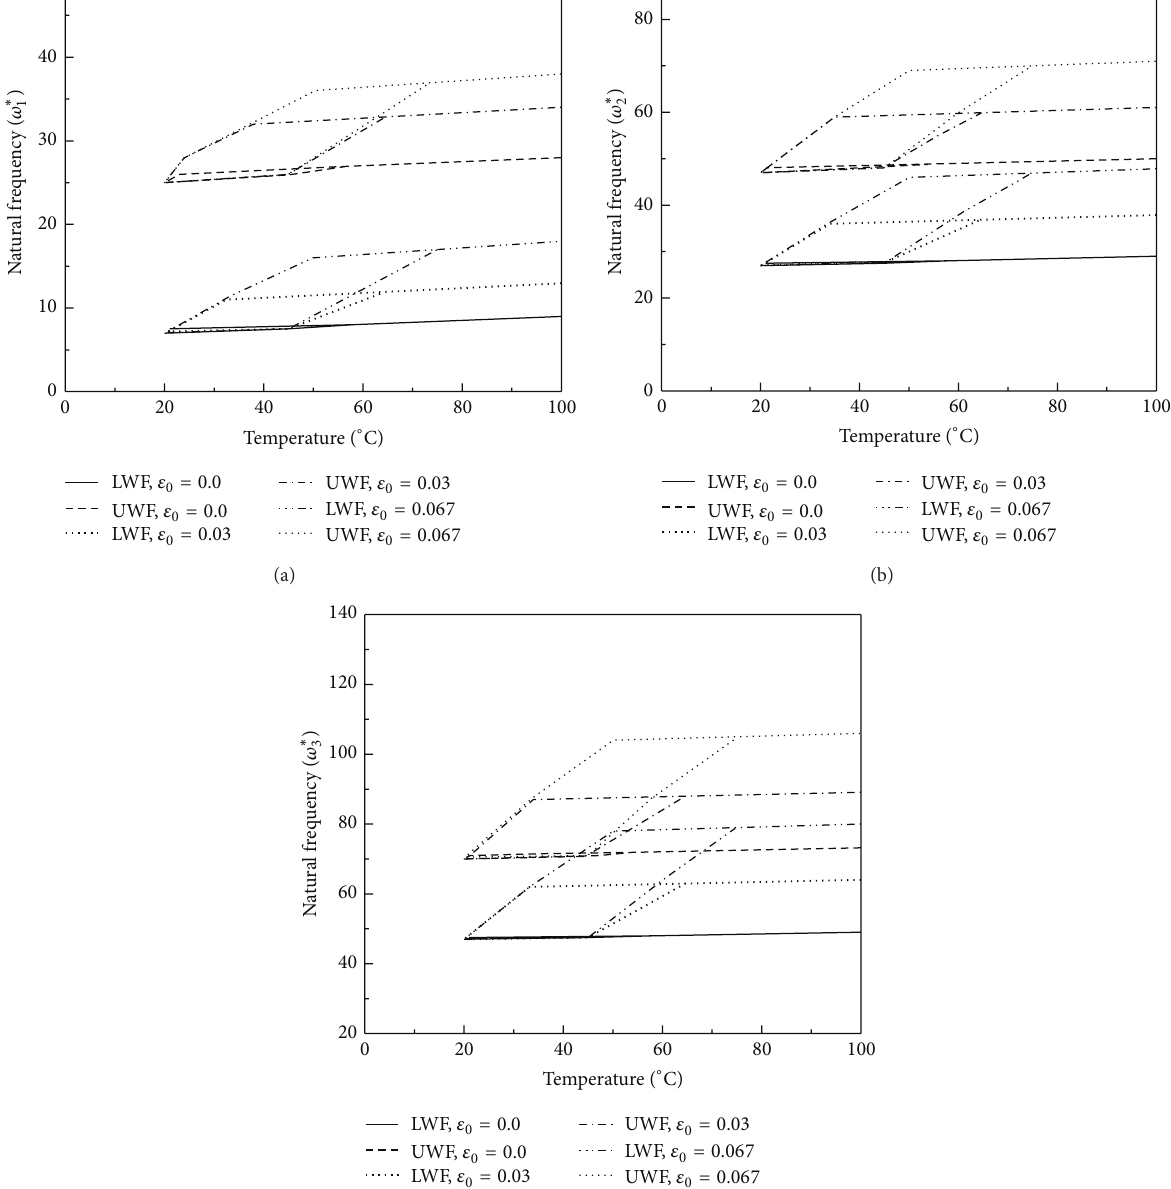
The temperature is increased from 0 ∘ C to 100 ∘ C and then decreased from 100 ∘ C to 0 ∘ C. The phase transformation from the martensite to the austenite ( 𝑀 → 𝐴 ) is induced in the SMA wires during heating, and the phase transformation from the austenite to the martensite ( 𝐴 → 𝑀 ) is